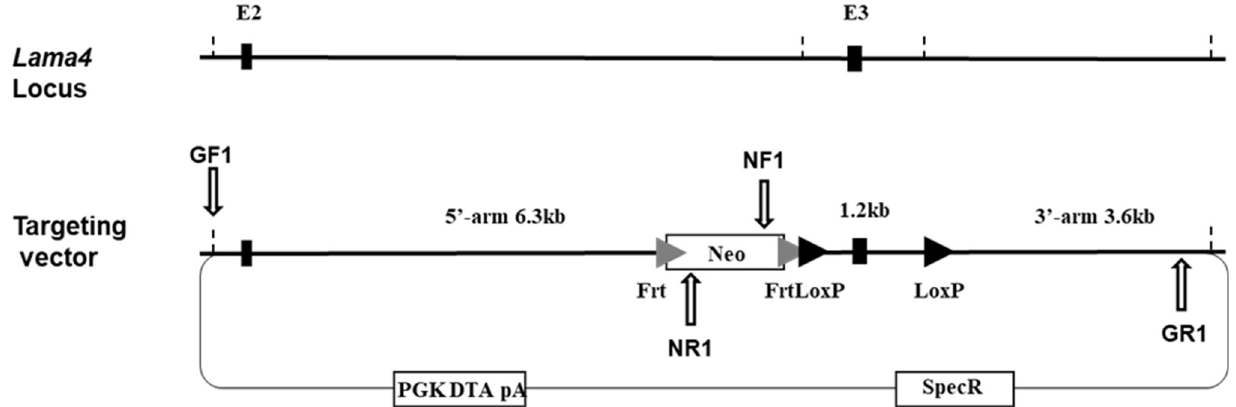
Figure 1. Genetic strategy and targeting vector for generation of Lama4 loxP/loxP mice. White arrows indicate sites of primers used to determine correct homologous recombination in embryonic stem cell clones surviving positive/negative selection (GF & GR = genomic forward and reverse, respectively; NF and NR = Neo forward and reverse, respectively). Primer sequences appear in Appendix